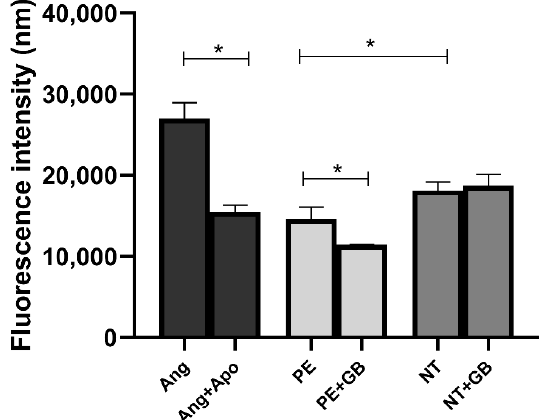
Figure 4. Intracellular reactive oxygen species (ROS) evaluated in 30 min by fluorescence of 2,7-dichlorodihydrofluorescein diacetate (DCFH) in the supernatant of human umbilical vein endothelial cells (HUVECs) incubated with 400 µM of angiotensin II (Ang), 100 µM of apocynin (Apo), 20% ( v / v ) pooled plasma from NT (n = 10) and PE (n = 10) (a) and GB (100 µM) for 24 h. Data are reported as means ± SEM. Comparisons between groups were assessed by One-Way ANOVA followed by Tukey’s Test. * ( p < 0.05).